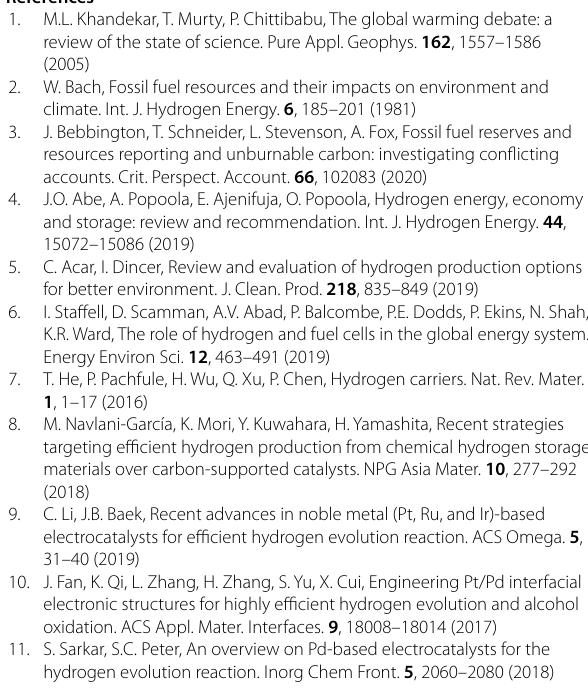
N atoms. Figure S2. High-resolution ( a ) S 2p, ( b ) N 1s, and ( c ) O1s XPS profiles of the WS2 NFs. Figure S3. High-resolution ( a ) S 2p, ( b ) N 1s, ( c ) O1s, and ( d ) C1s XPS profiles of the WS2-WC-WO3 NH spheres. Figure S4. ( a ) CV curves and ( b ) TOF of the WS2 NFs. Figure S5. CV curves of the WS2-WC-WO3 NH composite at various scan rates ( a ) before and ( b ) after 1000 cycles and ( c ) TOF of the WS2-WC-WO3 NH composite. Table S1. Comparison of other electrocatalysts previously reported in